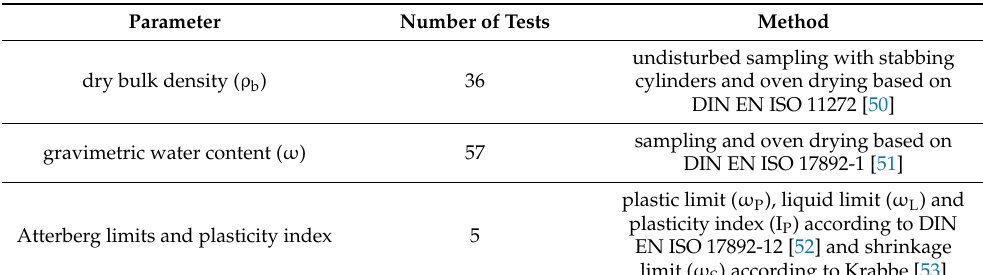
Table 1. Conducted field and laboratory investigations of soils and soil samples in the unsaturated zone in the range of the large-scale geothermal collector system (LSC) and the near low-temperature district heating and cooling